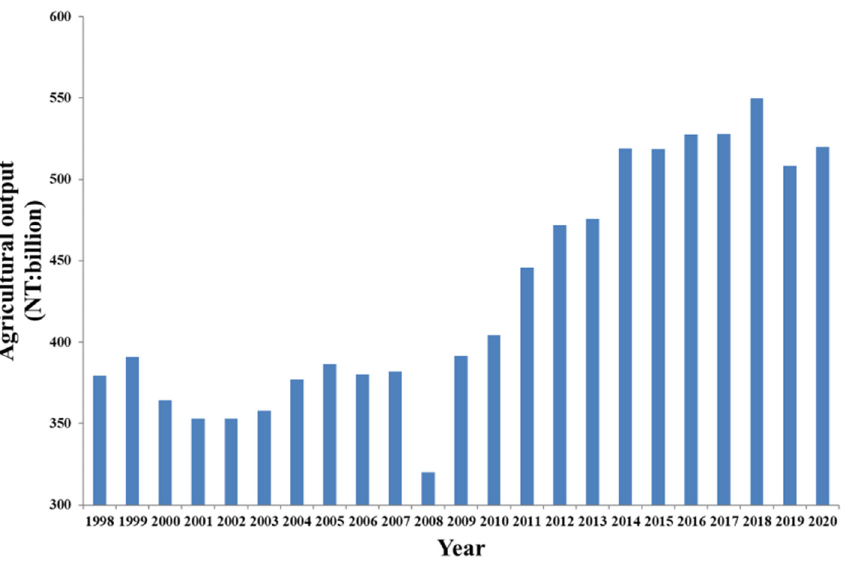
Figure 2. The annual total agricultural output from 1998 to 2020 in Taiwan.